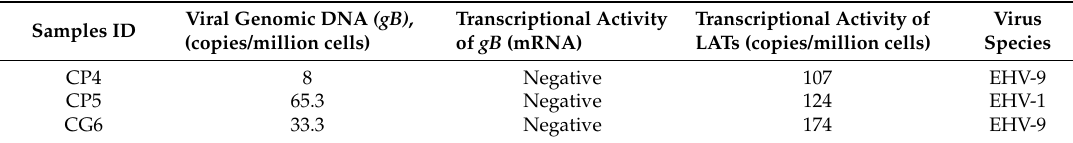
Table 2. Latent viral DNA and RNA copies tested by qPCR in